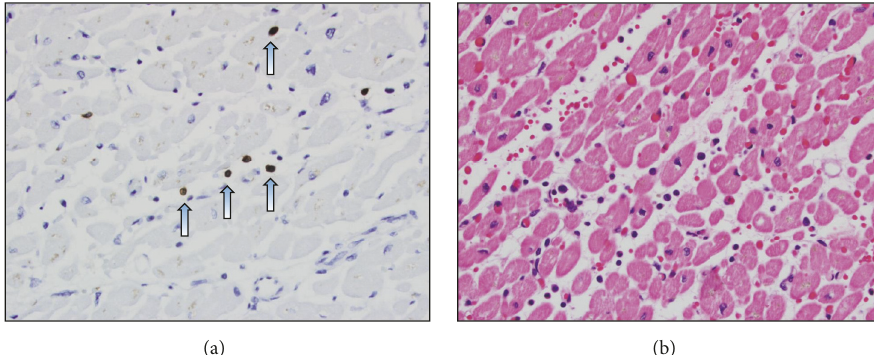
Figure3:(a)ImmunohistochemicalstainofCD3lymphocytesintheintraventricularseptum(indicatedbythearrows),400x.(b)Hemoxyline and Eosin stain of the intraventricular septum showing hemorrhage and myocyte necrosis,